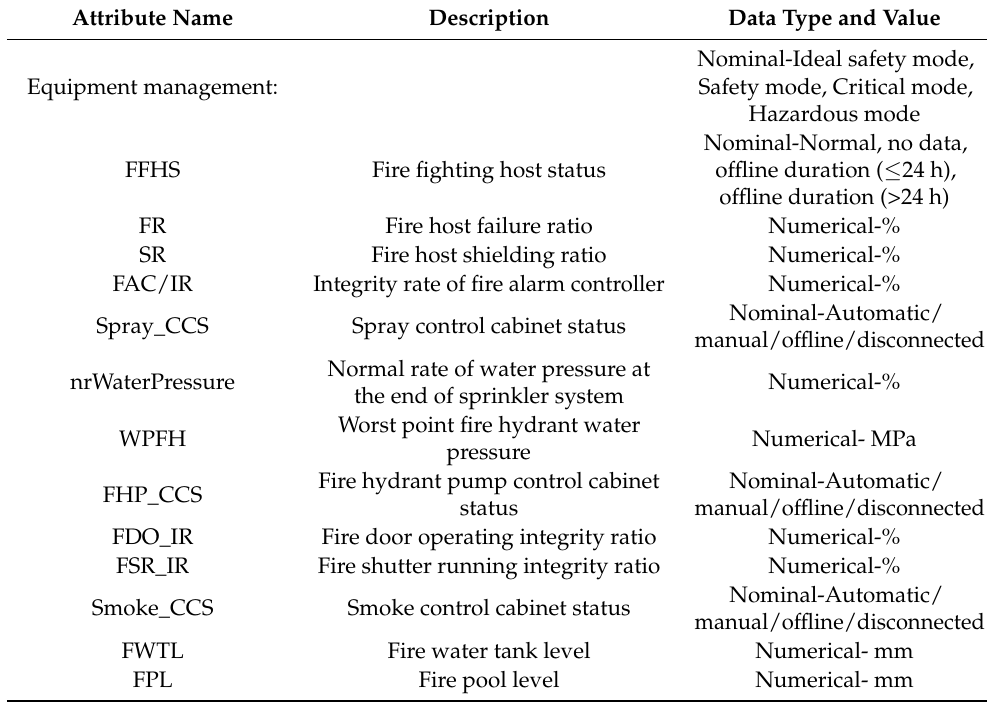
Table A2. Description of attributes from equipment management